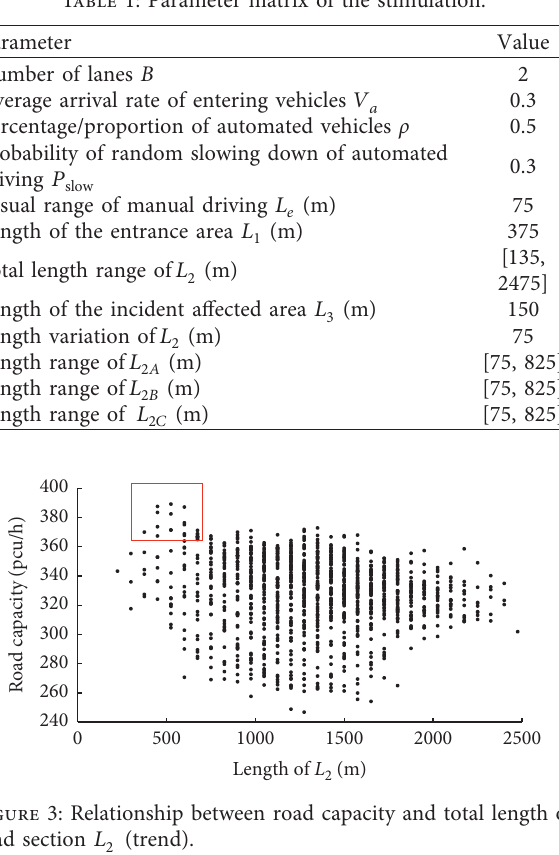
Table 1: Parameter matrix of the stimulation.